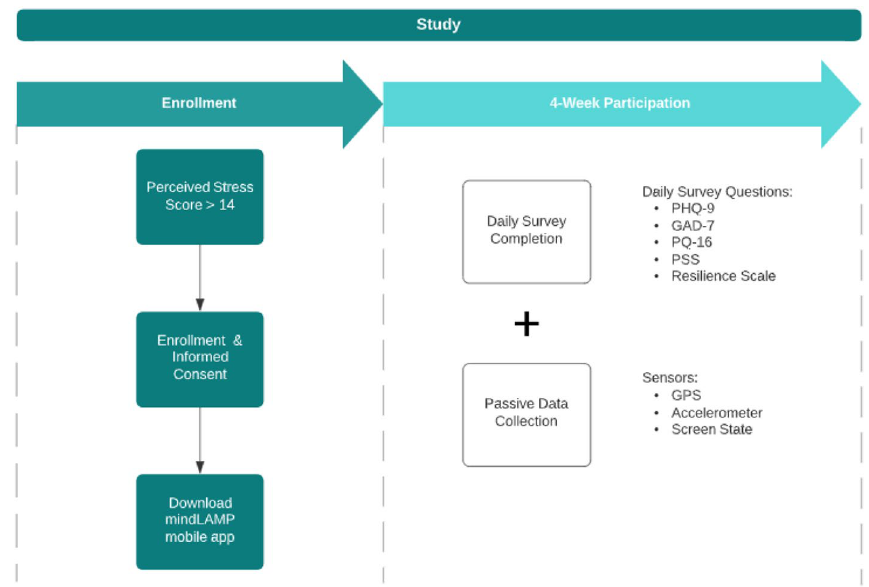
Figure 1. College study (n = 695).